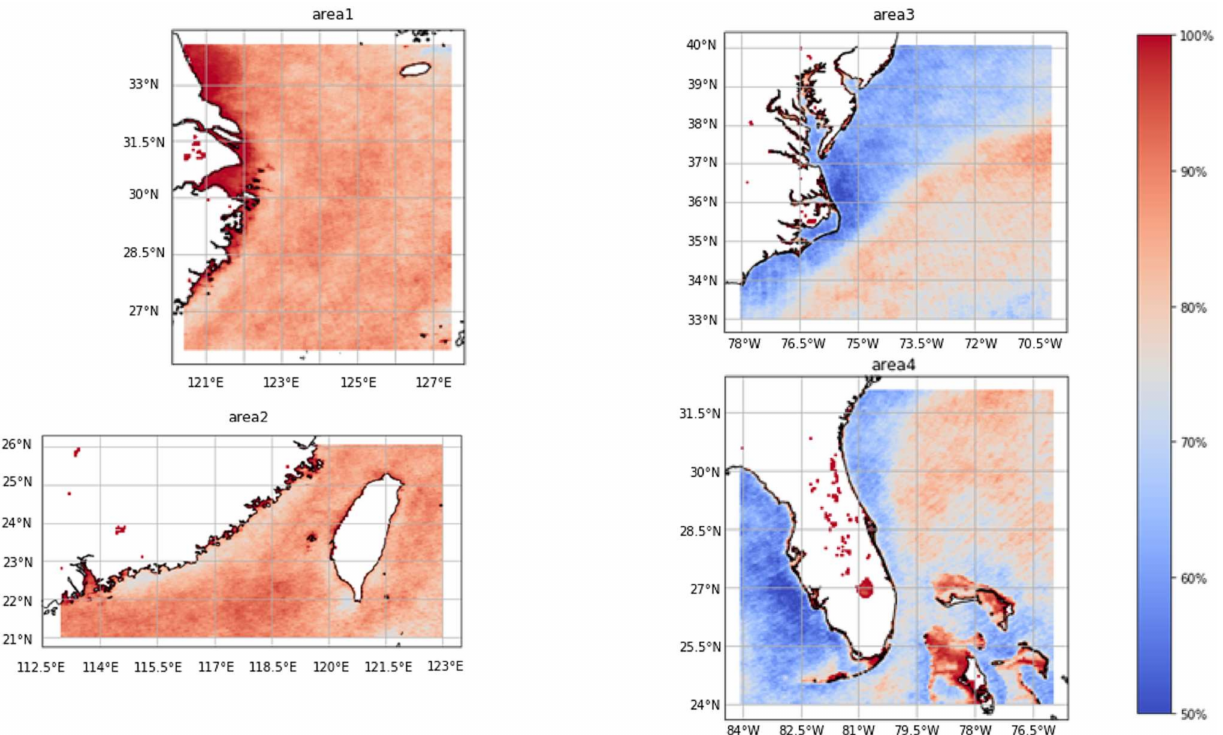
Figure 2. Missing rate of each pixel for the complete